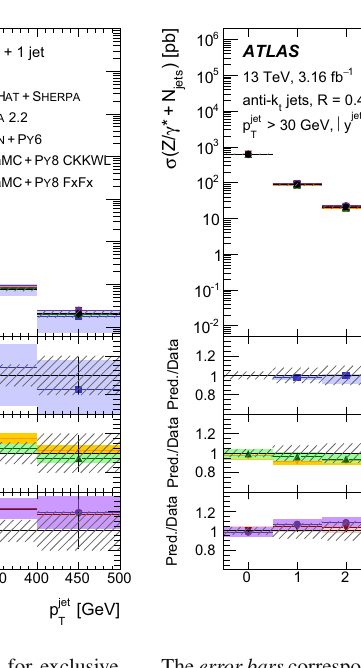
The error bars correspond to the statistical uncertainty, and the hatched bands to the data statistical and systematic uncertainties (including luminosity) added in quadrature. The details of the prediction uncer- tainties are given in the